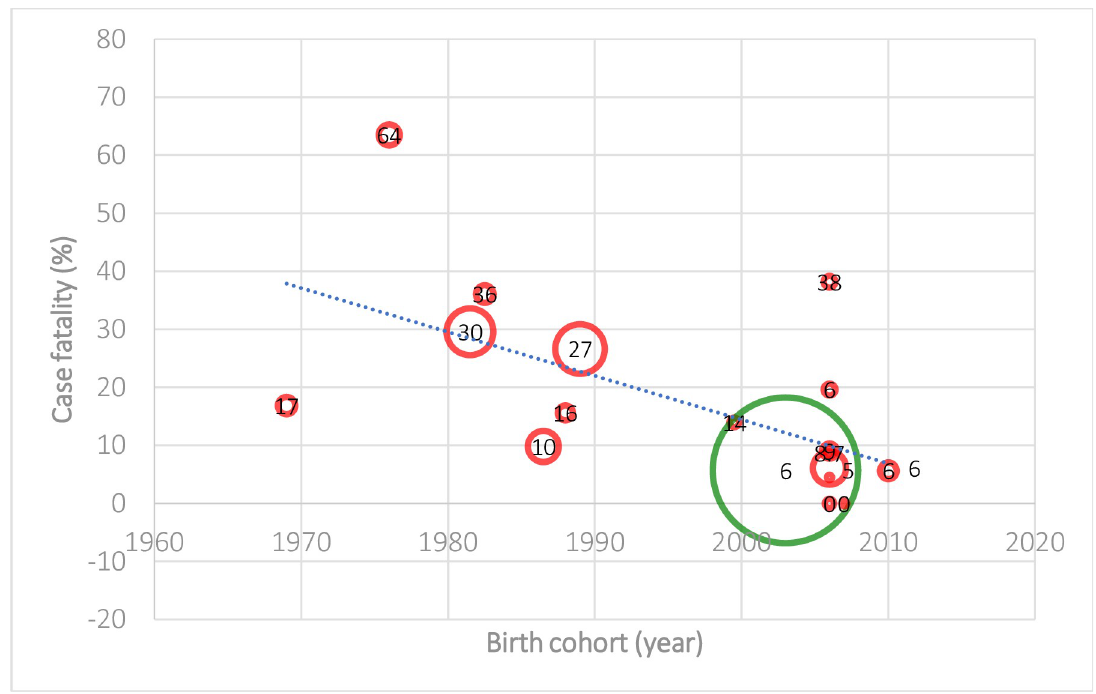
Fig 4. Neonatal case fatality from spina bifida in Australia, the U.S. and various European countries (Birth cohort: 1969–2010) [10,23,30,35,37–40,42,43].